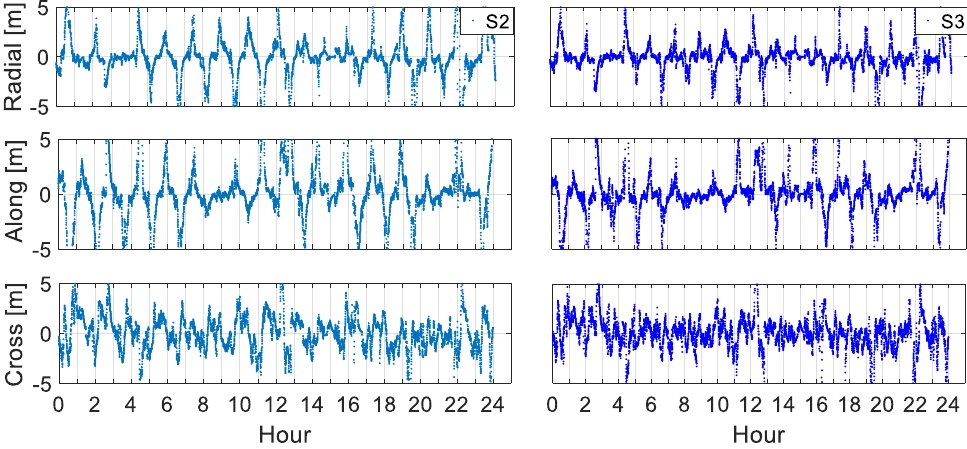
Figure 9. GRACE-A real-time POD results of Schemes 2 ( left ) and 3 ( right ).